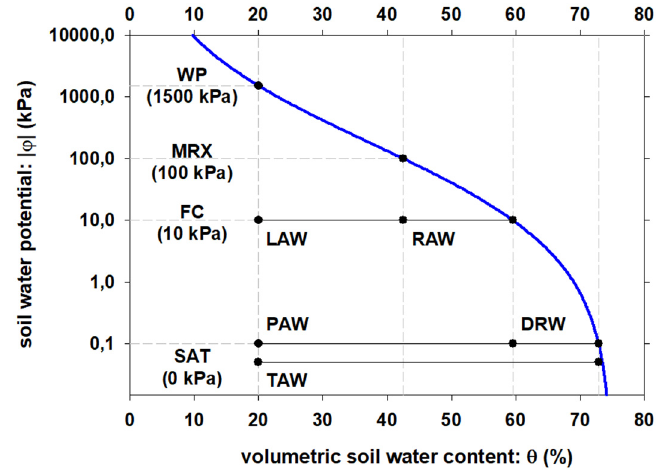
Figure 2. Graphical representation of the soil water capacitive indicators (TAW, PAW, DRW, LAW and RAW) as determined by the volumetric water content (%) corresponding to the characteristic water potentials (SAT, FC, MRX and WP) along the soil adsorption curve. (Read the text for explanations of acronyms and initialisms.)